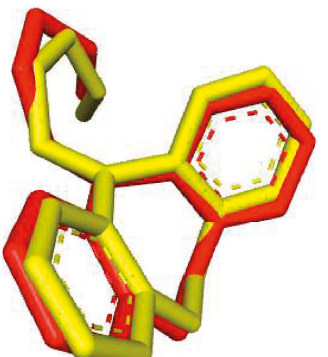
Figure 5: The docked pose (yellow) and the crystal structure conformation (red) of desipramine, the native ligand.